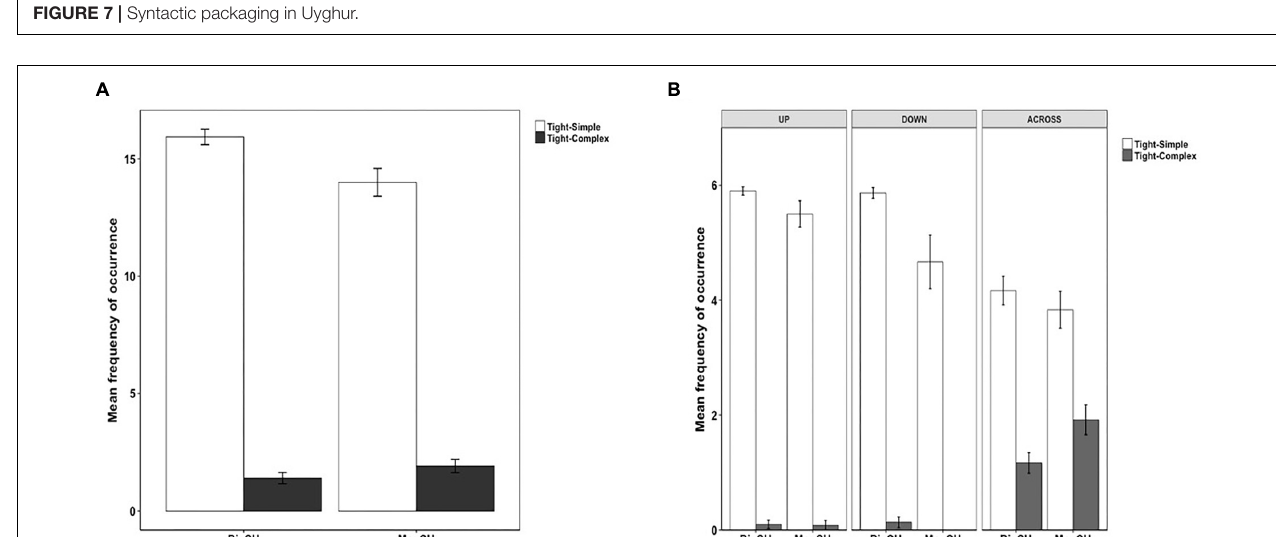
FIGURE 8 | Syntactic packaging in